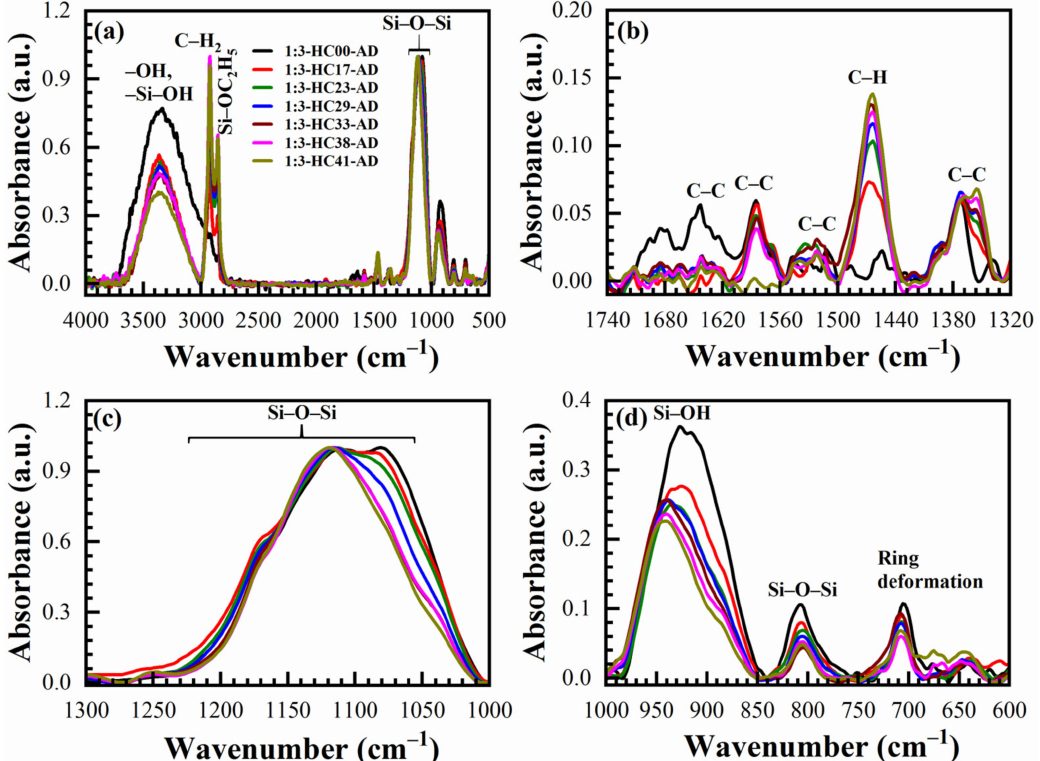
Figure 9. FTIR spectra of 1:3 ratio material as-deposited (AD) films with different template loadings (0 to 41 wt%, films numbered from HC17 to HC41) where ( a ) is the full FTIR spectra and ( b – d ) are the parts of the full FTIR